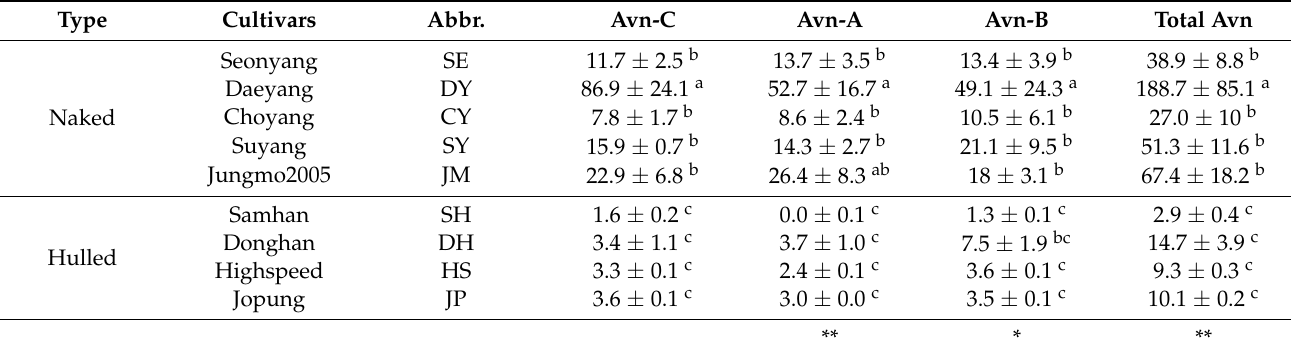
Table 1. Comparison of Avn contents in oat cultivars ( µ g/g).